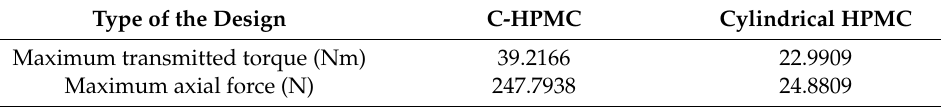
Figure 13. Axial force and transmitted torque of the traditional cylindrical HPMC with 1 mm axial displacement. Table 7. Comparison between the C-HPMC and traditional cylindrical HPMC.